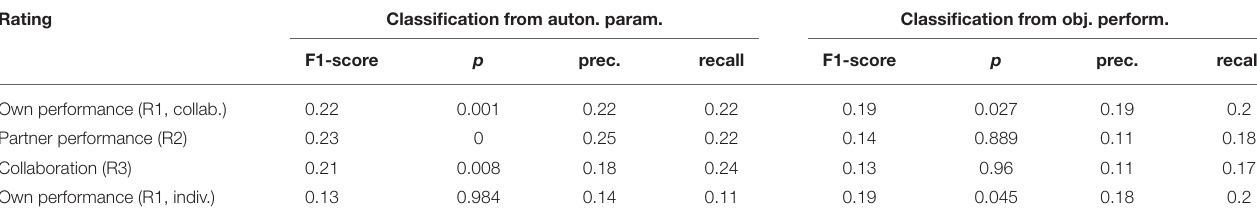
TABLE 4 | F1-scores, precision, and recall from leave-one-sample-out cross-validation and p -values from a randomization test. Rating Classification from auton. param. Classification from obj. perform. F1-score p prec. recall F1-score p prec. recall Own performance (R1, collab.) 0.32 0 0.43 0.26 0.19 Partner performance (R2) 0.37 0 0.47 Own performance (R1, indiv.)